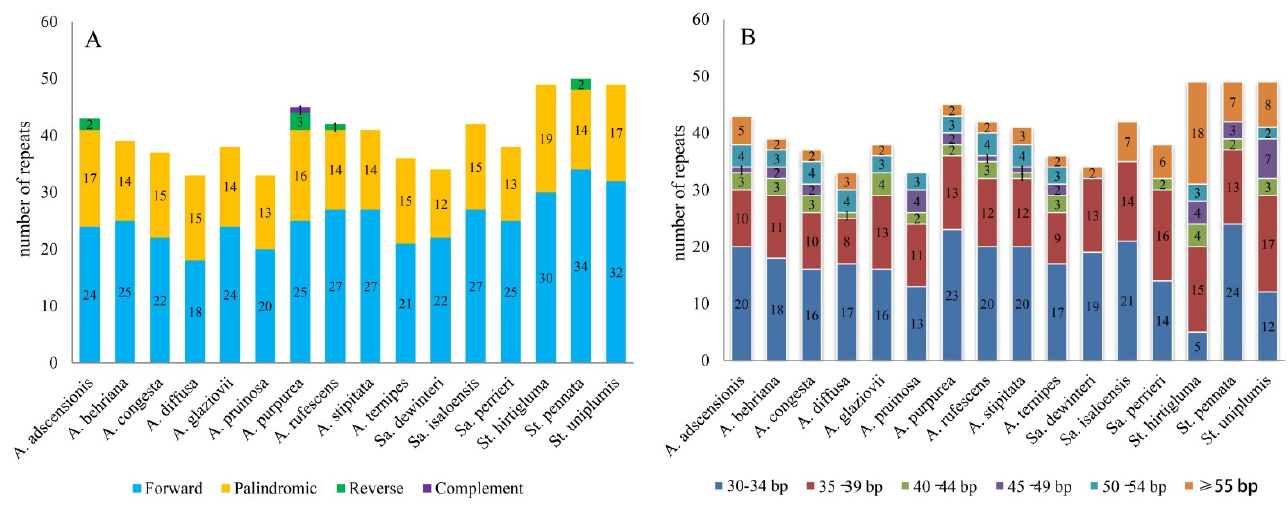
Figure 2. Repeat sequence analysis of plastomes in 16 Aristidoideae species. ( A ) The number of four types of repeats in different species. ( B ) The number of repeats with different lengths in different species. Table 3. Correlation analysis between cpSSRs and plastome size and CG content in 16 Aristidoideae species. .Term